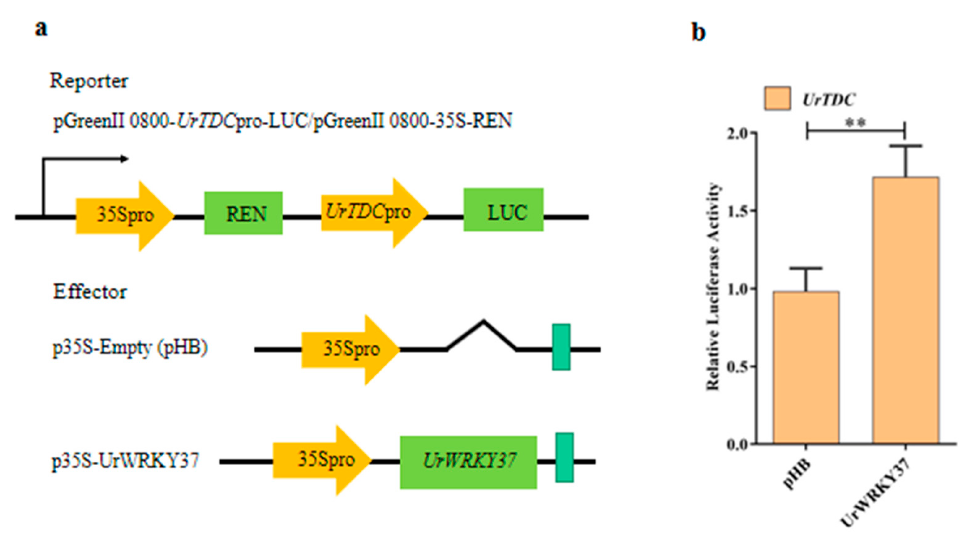
Figure 7. Activation of UrTDC promoter by UrWRKY37 in dual-luciferase (Dual-LUC) assay. ( a ) Schematic diagram of the reporter and effector plasmids used in the Dual-LUC assay. The UrTDC promoter sequence was inserted into pGreenII 0800 vector containing LUC and Renilla luciferase (REN) as the reported plasmid. The effector pHB plasmid containing UrWRKY37 coding sequences driven by the 35S promoter. The binding ability of UrWRKY37 to the UrTDC promoter is indicated by the LUC/REN ratio. ( b ) The promoter activity of the UrTDC promoter is expressed as the LUC/REN ratio. Error bars indicate the standard error of five biological replicates. ** denotes a statistically remarkable